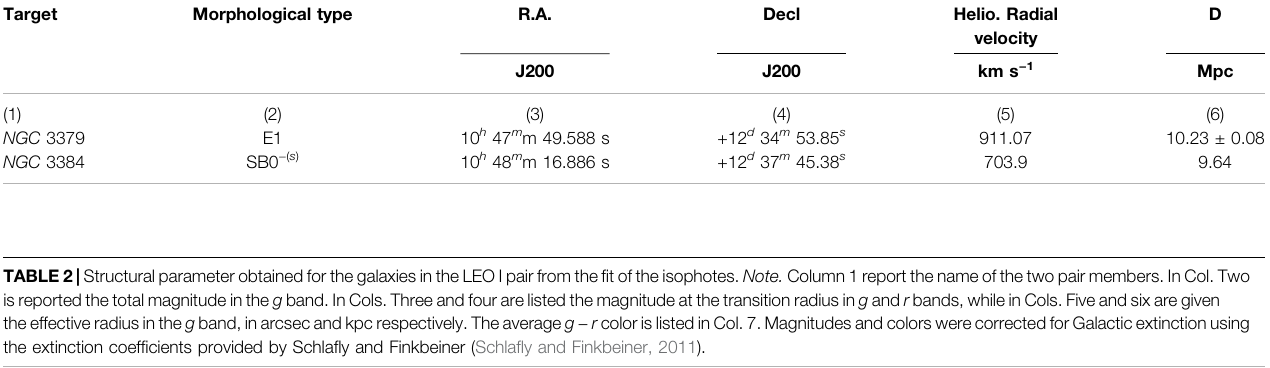
TABLE 1 | Properties of the galaxies in the LEO I pair. Note. Column 1 report the name of the two LEO I pair members. In Col. Two is given the morphological type. In Cols. Threeandfourarelistedthecelestialcoordinatesofeachgroupmember.InCol.Fiveislistedtheheliocentricradialvelocity,andinCol.Sixisreportedthedistancesofthe pair members. The distance for NGC 3384 was estimated using the relationship: D = V He H − 1 0 , with H 0 = 73 km s − 1 Mpc − 1 (Riess et al., 2018). Target